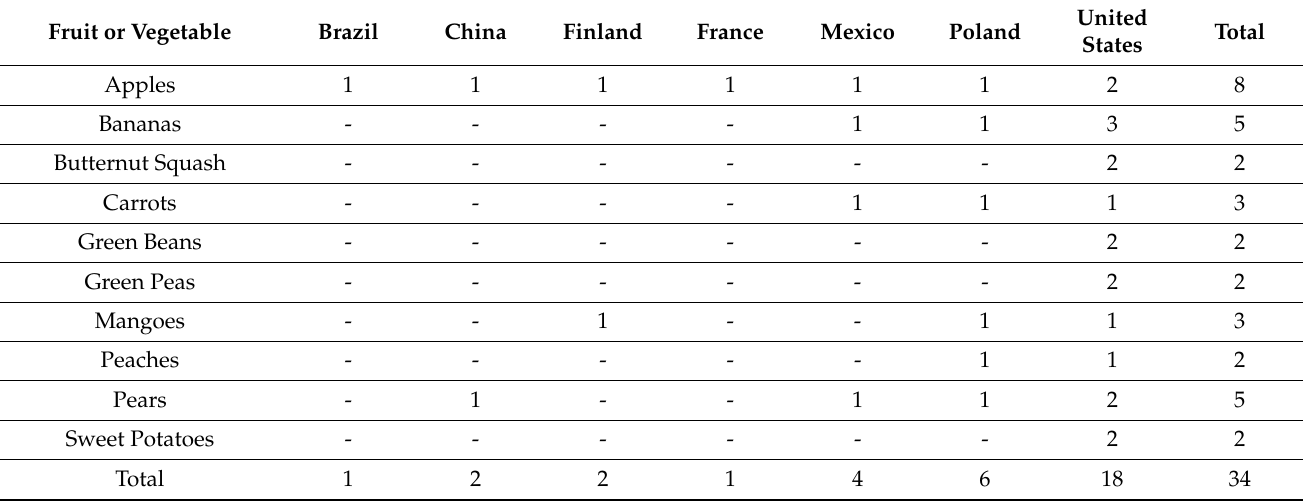
Table 1. Commercially prepared infant puree count for each fruit and vegetable by country-specific